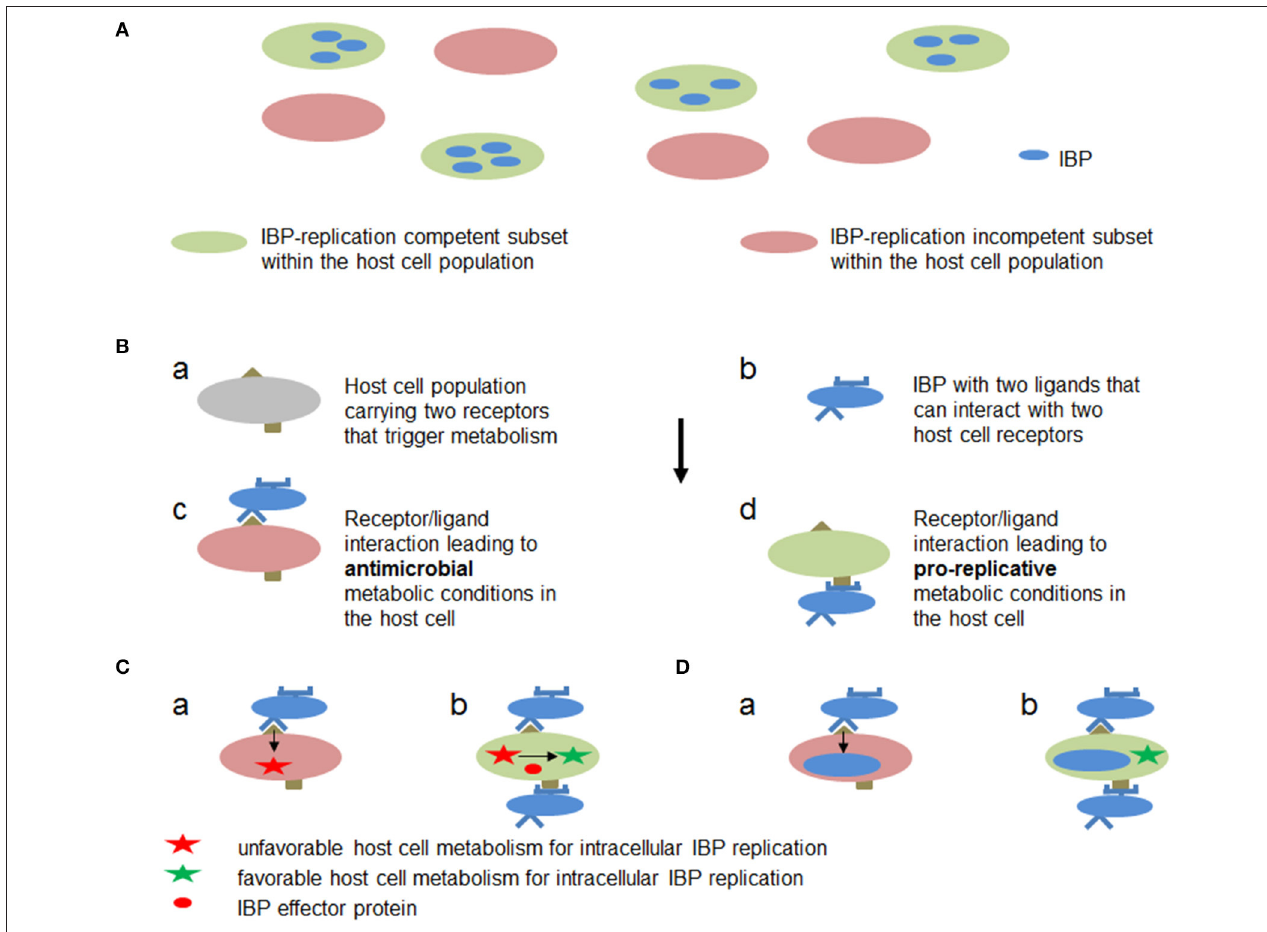
FIGURE 7 | Hypothetic metabolic host cell conditions and interactions between host cell targets and IBP components leading to metabolic conditions in the host cell that are favorable or adverse for intracellular replication of IBPs. (A) Within a host cell population (e.g., MPs) metabolically different subsets (a and b) may already exist which allow (blue) or inhibit (yellow) active metabolism and hence replication of the IBP. (B) Cells within a host cell population may carry two receptors (a) which can interact with two different ligands of the IBP (b). One receptor/ligand combination (c) leads to an antibacterial metabolic host cell state (red), while the other (d) triggers metabolic host cell conditions that allow intracellular replication of IBP (green). (C) IBP (yellow circle) is internalized by the interaction of a host cell receptor (blue half circle) that triggers phagocytosis of the IBP but induces at the same time a host cell metabolism (a) that is unfavorable for intracellular IBP replication (red star). However, before or during internalization (b) the IBP may translocate an effector protein (red circle) via specific secretion (injection) systems that alters the host cell metabolism to become favorable for IBP replication (green star). (D) The IBP activates by a first interaction (a) a host cell metabolism with bacteriocidal activity. The IBP may inactivate, however, by a second bacterial ligand/host cell receptor interaction (b) the bacteriocidal activity thereby rendering the host cell metabolism favorable for IBP replication (green